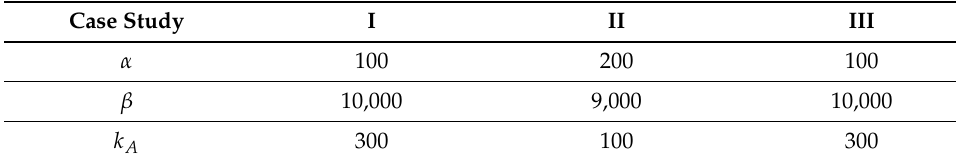
Table A1. Summary of gain values used for simulations.